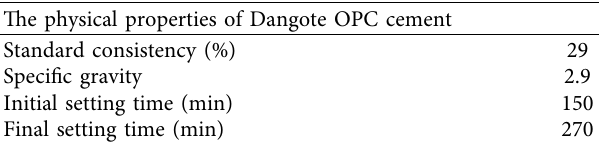
Table 4: Setting time, specific gravity, and standard consistency of the cement.